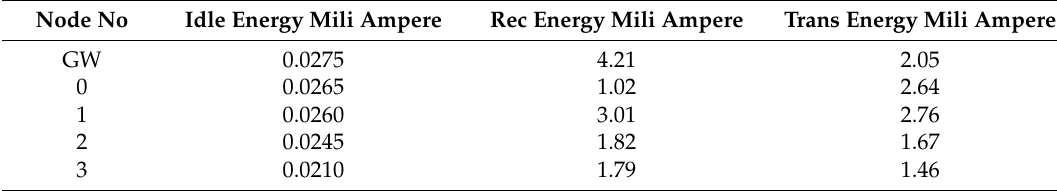
Table 7. Energy Measurements during rainfall on node 0 (Modified